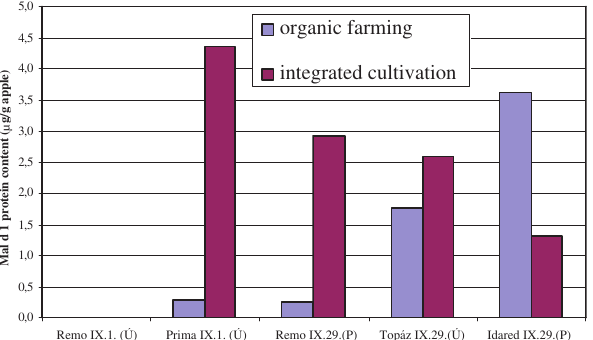
Figure 2. Protein content of Mal d 1 allergen fraction from apple cultivated under organic farming and integrated condition